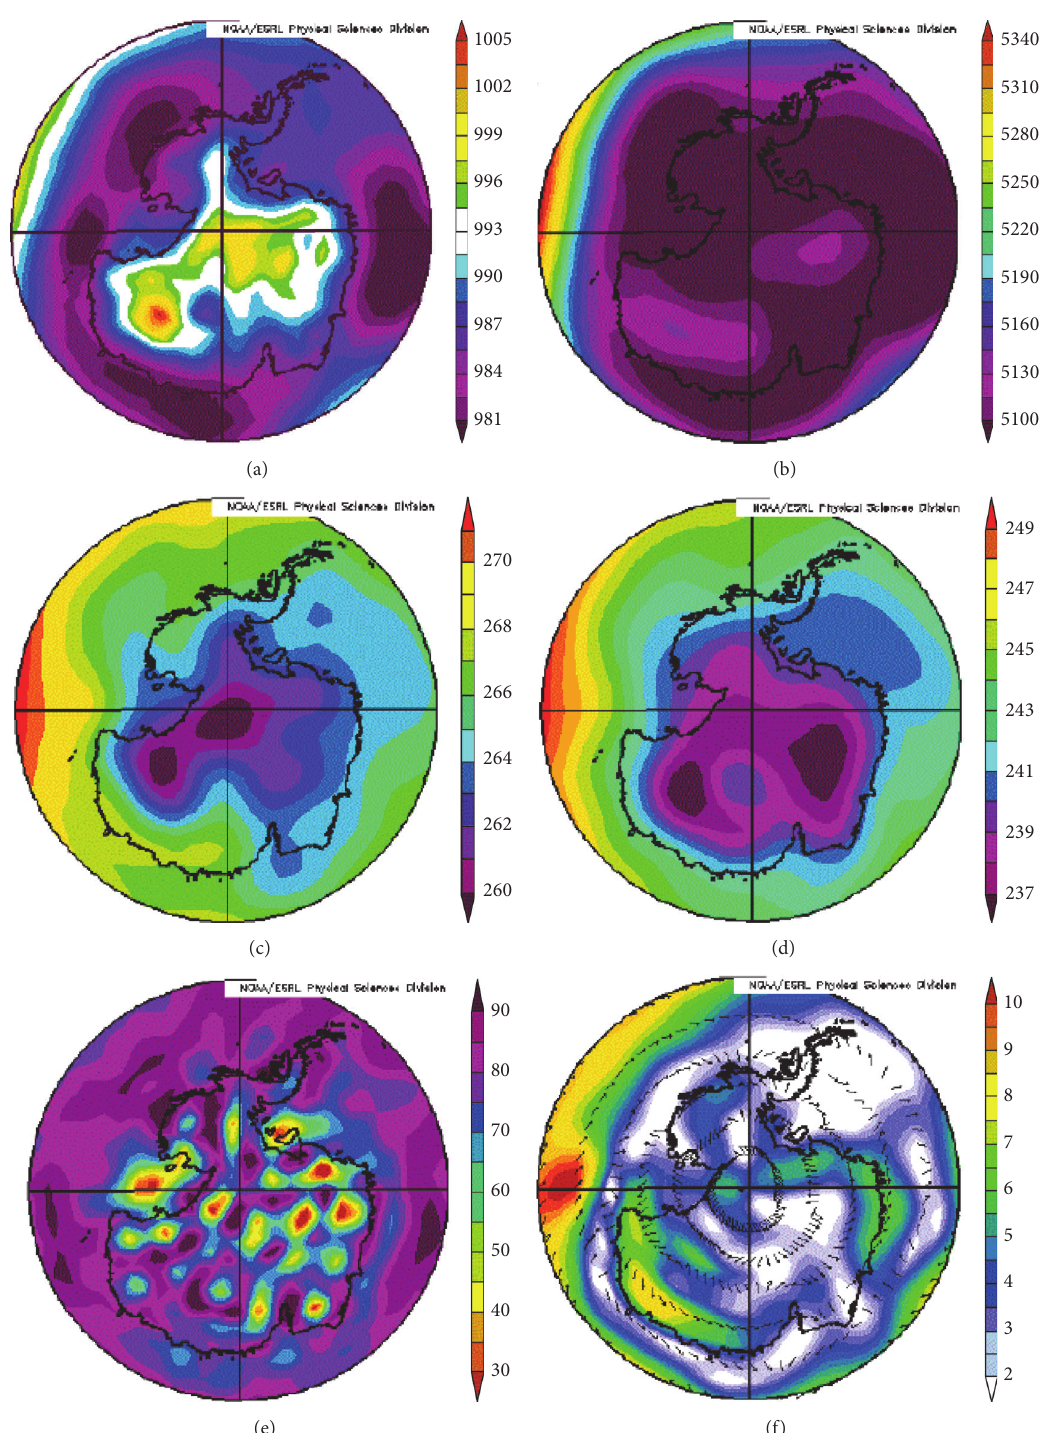
Figure 3: Mean fields over the detected 21 days: (a) mean sea-level pressure (hPa); (b) 500 hPa geopotential height (gpm); (c) 850 hPa air temperature (K); (d) 500 hPa air temperature (k); (e) 850 hPa relative humidity (%); and (f) 1000 hPa wind vector and speed (m/s)